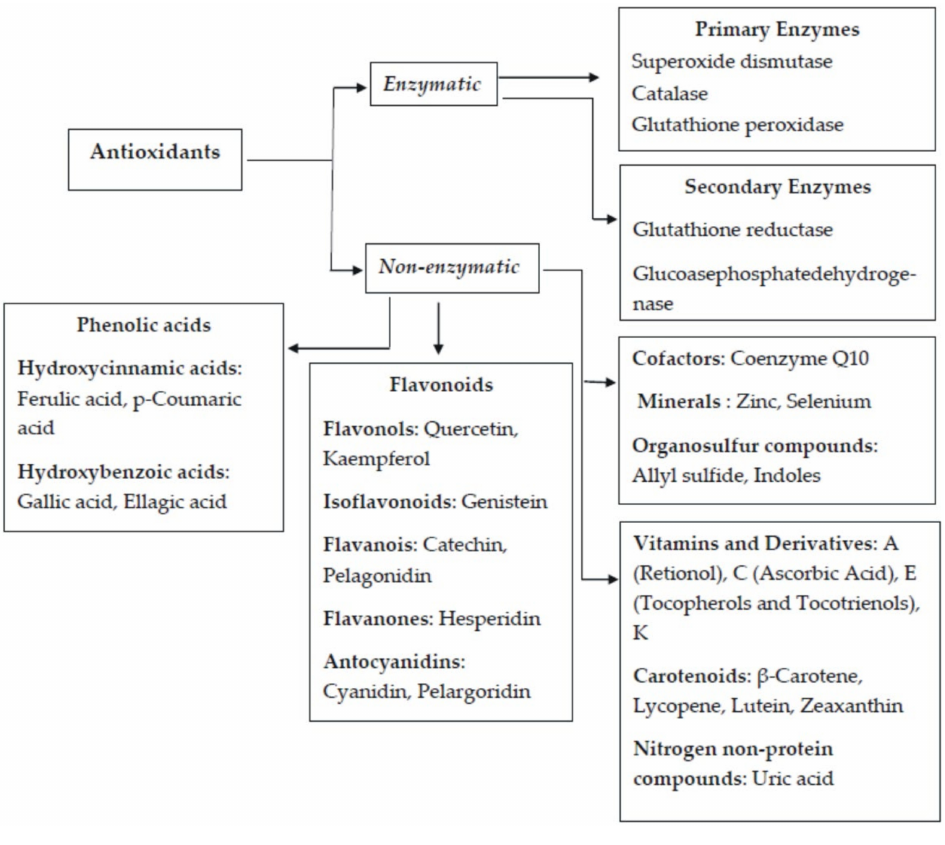
Figure 1. Classification of antioxidants [6].